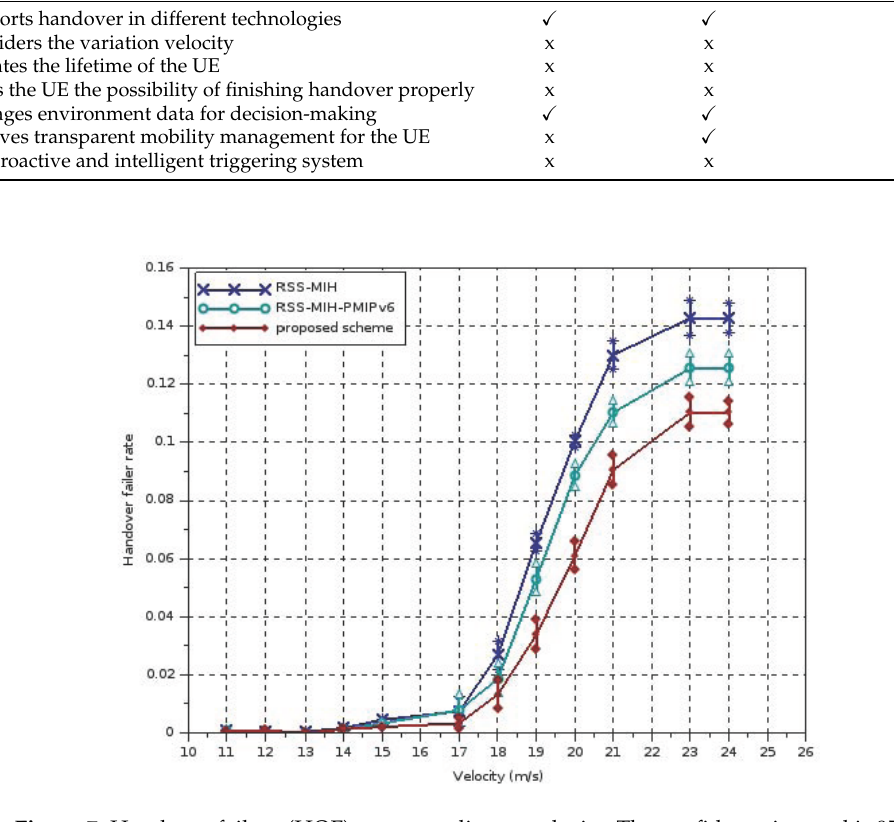
Figure 7. Handover failure (HOF) rate according to velocity. The confidence interval is 95%.